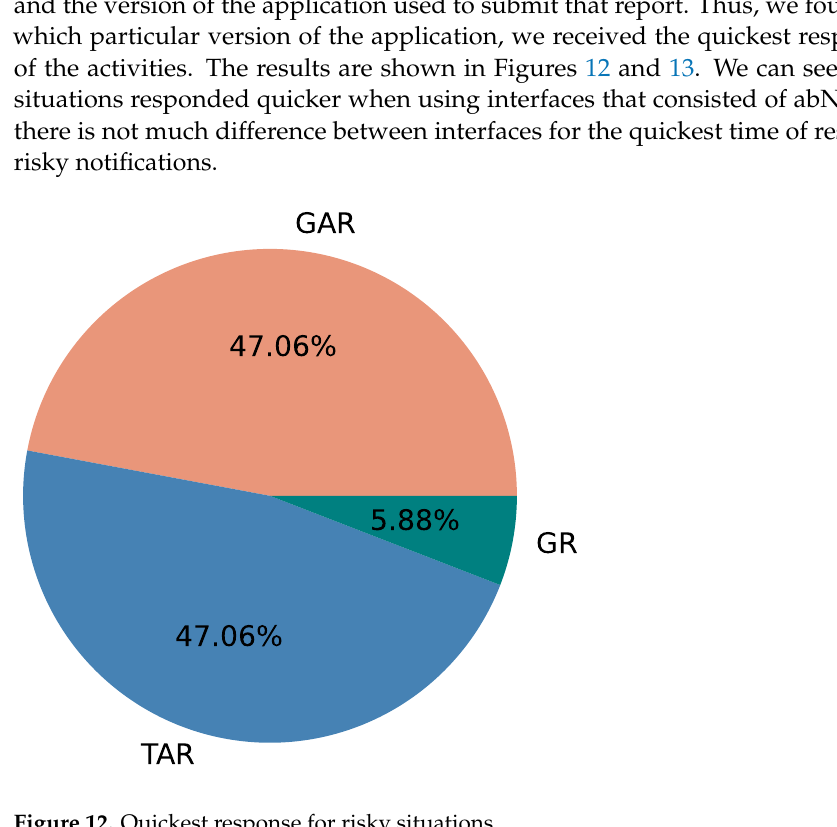
Figure 12. Quickest response for risky